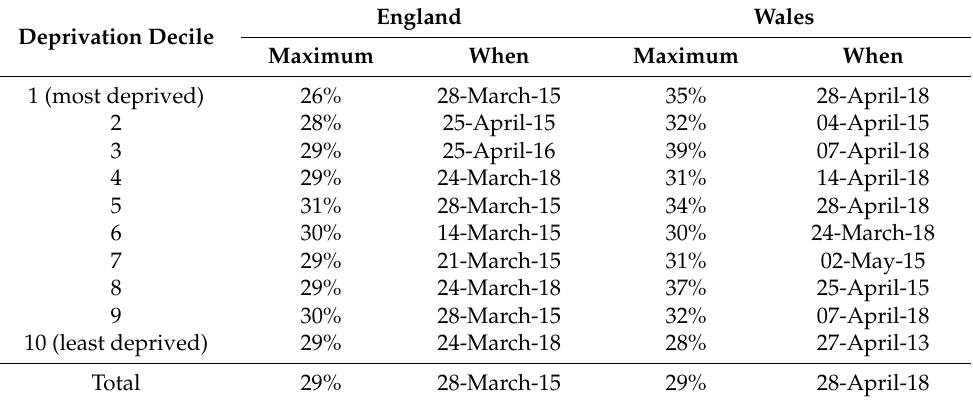
Table 4. Maximum value of EWM for small areas ranked by deprivation decile in England and Wales (2005–2018) using weekly data, plus the time at which the rolling EWM (weekly data) reaches its maximum value. England Wales Deprivation Decile Maximum When